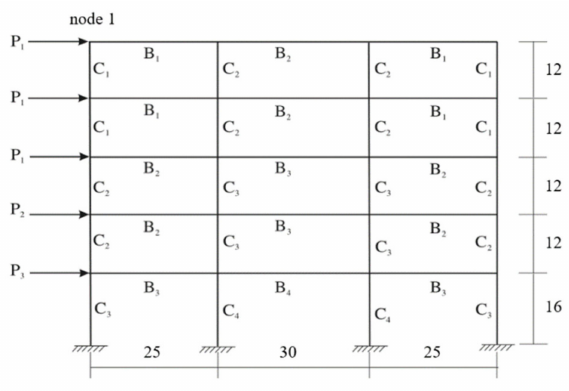
Figure 12. Three-bay five-story linear elastic frame